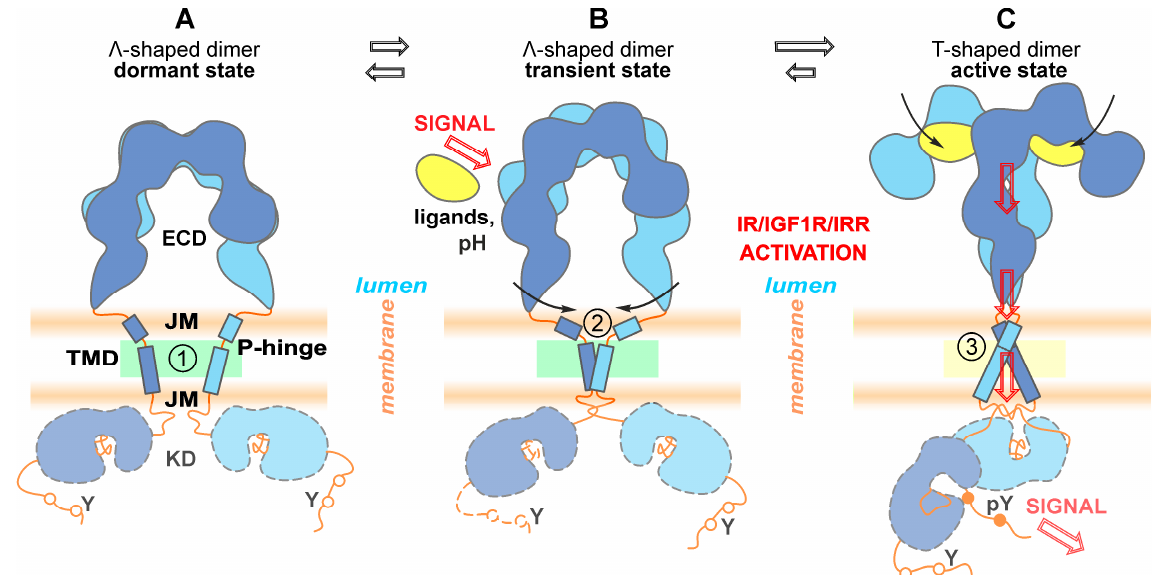
Figure 5. Schematic illustration of the key stages of the proposed mechanism of signal transduction by RTK of the insulin receptor subfamily. ECD—ectodomain, JM—juxtamembrane region, TMD—transmembrane domain, KD—kinase domain; P-hinge—flexible linker adjacent to intramembrane proline. Left to right: proposed structural rearrangements of the receptors inferred from structural information obtained in this work (indicated by numbers in circles) and available literature data. ( A ) Inactive state: disulfide-linked ECD is in unliganded Λ -shape conformation, separated TMD helices are bending in flexible P-hinge (marked with 1 in a circle) adjacent to intramembrane proline. The lipids surrounding TMD are relatively flexible (shown by green). ( B ) The ligand binding (in the case of InsR and IGF1R) or pH increase (in the case of IRR) induces conformational changes in ECD that bring their C-termini closer together (indicated by black arrows), resulting in transient dimerization of TMDs via C-terminal hydrophilic (polar) patterns, while the TMD helix bending in a flexible P-hinge allows to compensate for the remaining separation of ECD C-termini (marked with 2 in a circle). ( C ) Further switching of the receptor dimer accompanied by rearrangements of all domains into the active state allows phosphorylation of the target tyrosine residues (pY) followed by the stimulation of the downstream signaling cascades. The TMD helices dimerize via N-terminal hydrophilic (polar) patterns formed again by TMD straight-conformation (marked with 3 in a circle) with surrounding lipids immobilized on the helix surface (shown by yellow).